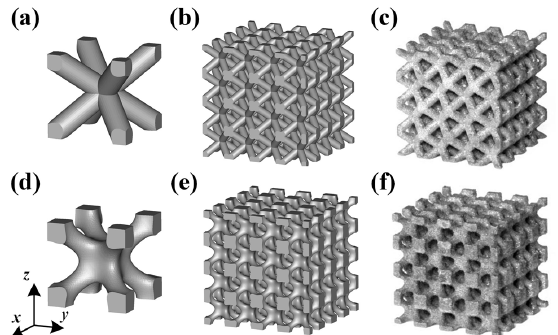
Figure 1. The relationship between volume fraction ( (cid:2025) ∗ ) and parameter (cid:1872) .